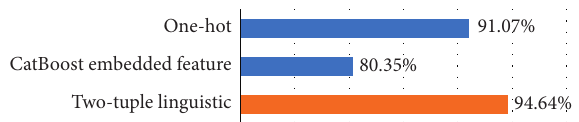
Figure 4: Classification accuracy of three preprocessing